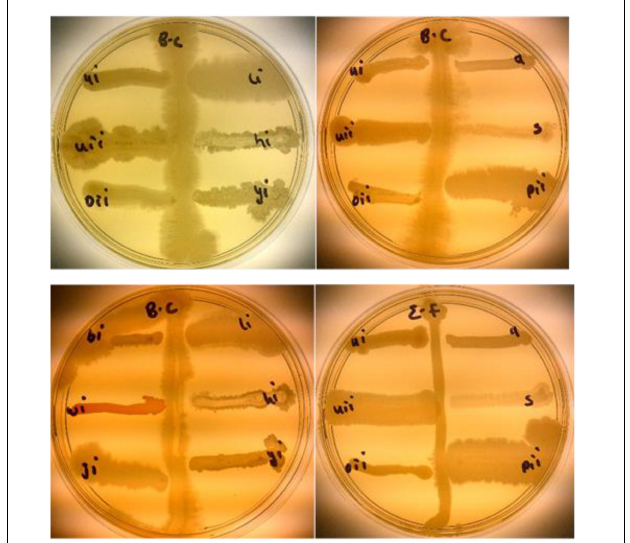
TABLE 3 | A percentage area of inhibition for selected PGPR agents.